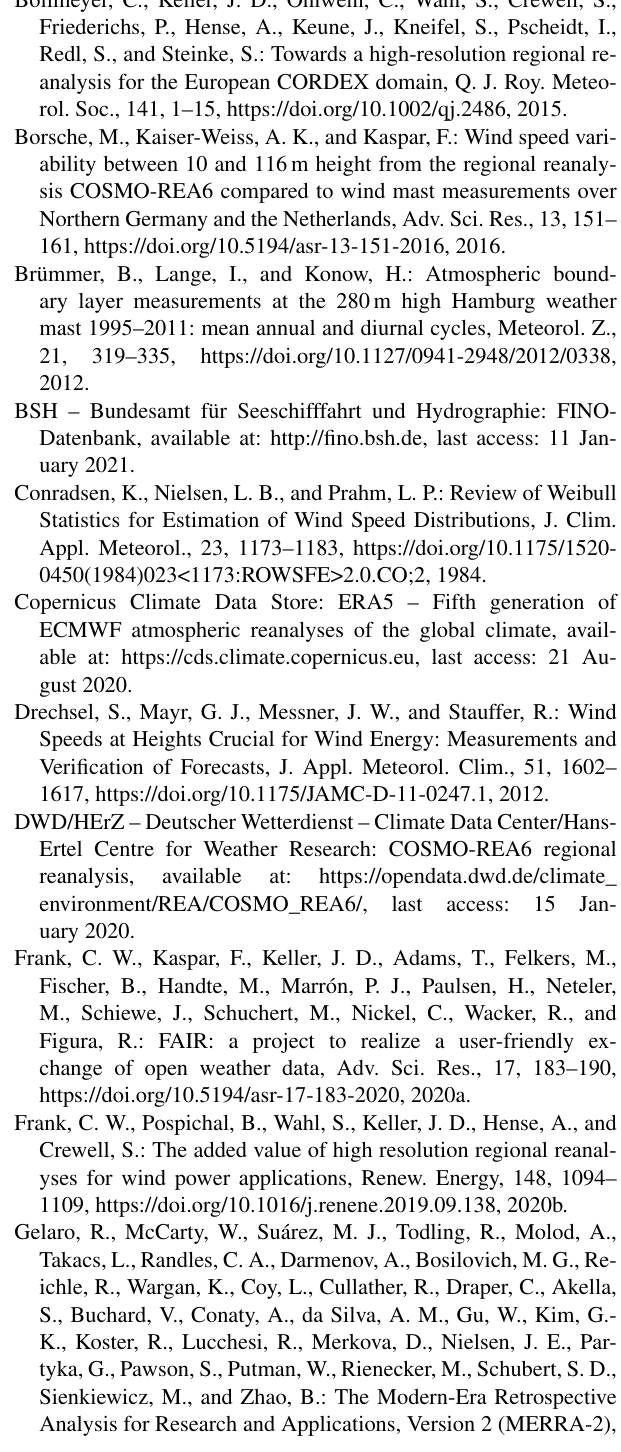
Figura, R.: FAIR: a project to realize a user-friendly